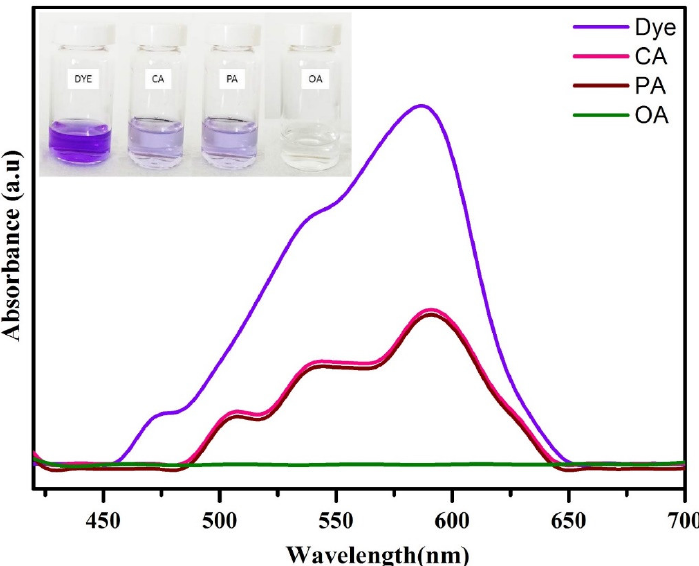
Figure 6. CV dye-degradation efficiency of WO 3 nanoparticles synthesized by using different chelating agents.